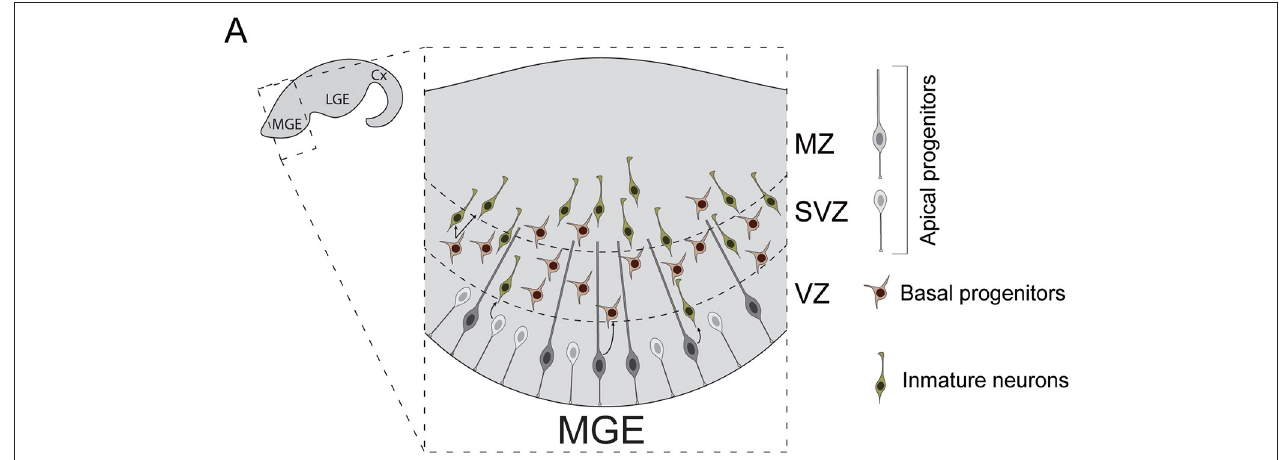
FIGURE 2 | Neurogenesis in the mouse medial ganglionic eminence. (A) Diverse types of progenitor cells underlie the genesis of cortical interneurons in the embryonic subpallium. Apical progenitors reside in the VZ and divide to generate neurons and basal progenitors. Basal progenitors migrate to the SVZ where they divide to generate post-mitotic interneurons. These neurons then migrate to the MZ and leave the MGE to invade the developing cortex. Cx, cortex; LGE, lateral ganglionic eminence; MGE, medial ganglionic eminence; VZ, ventricular zone; SVZ, subventricular zone; MZ, marginal